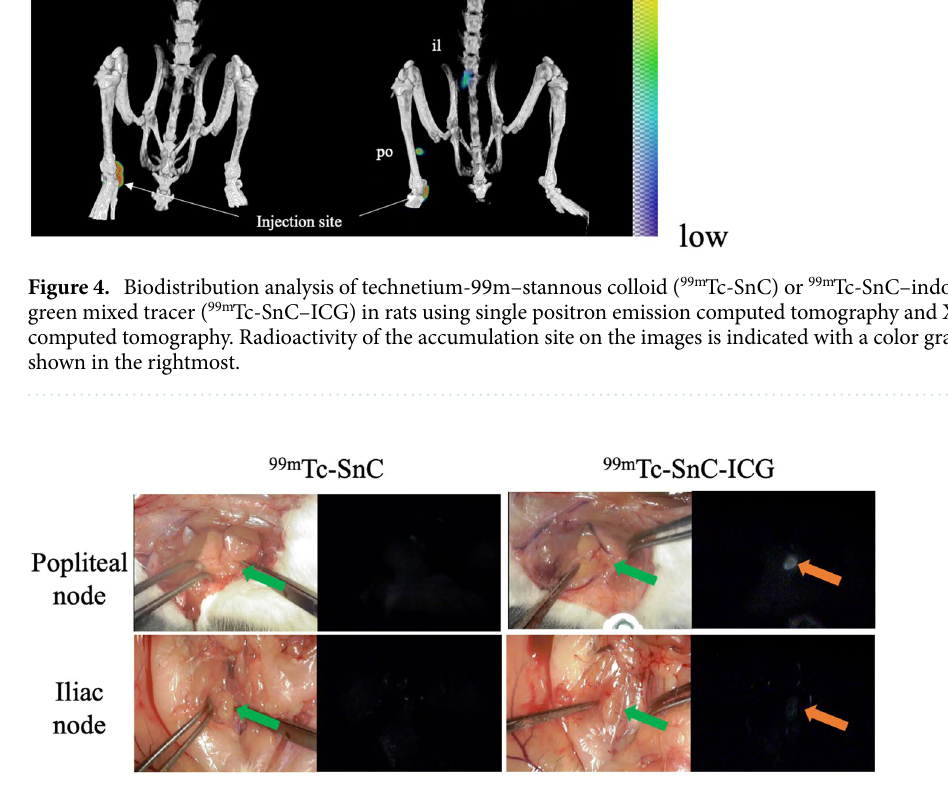
Figure 5. Appearance of regional lymph nodes (LNs) after the administration of technetium-99m–stannous colloid ( 99m Tc-SnC) or 99m Tc-SnC–indocyanine green mixed tracer ( 99m Tc-SnC–ICG) using bright-field (left) and near-infrared fluorescence (right) cameras. The arrows indicate regional LNs. Fluorescent nodes are rather ambiguous in this figure because these images were extracted from movies captured by NIR fluorescence camera with a long focal distance for clinical use and high background due to NIR surface-reflections. These nodes were obviously identified with original movies S5 (popliteal node with 99m Tc-SnC), S6 (iliac node with 99m Tc-SnC), S7 (popliteal node with 99m Tc-SnC–ICG), and S8 (iliac node with 99m Tc-SnC–ICG).